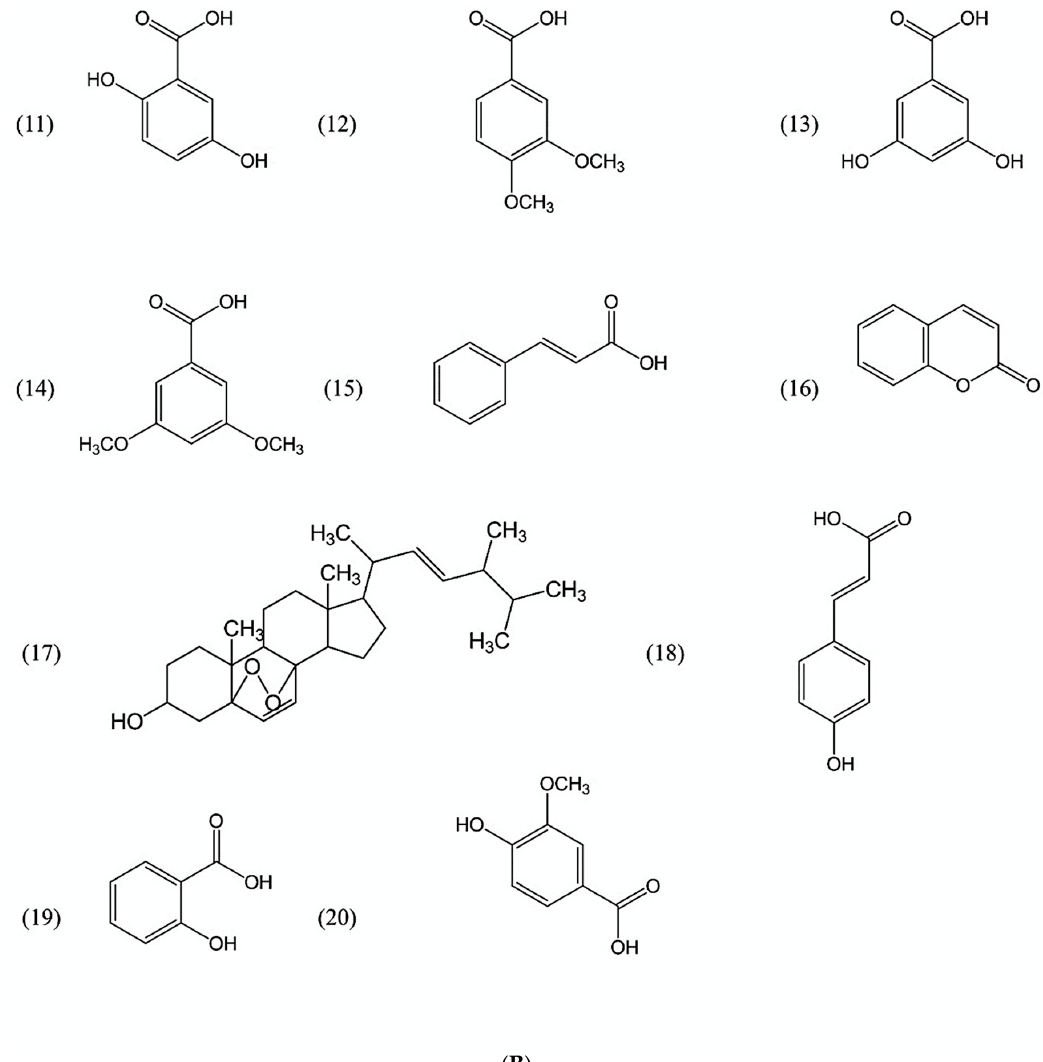
Figure 4. ( A ) Chemical composition of 10 allelochemicals in 9 OM rice cultivars identified as